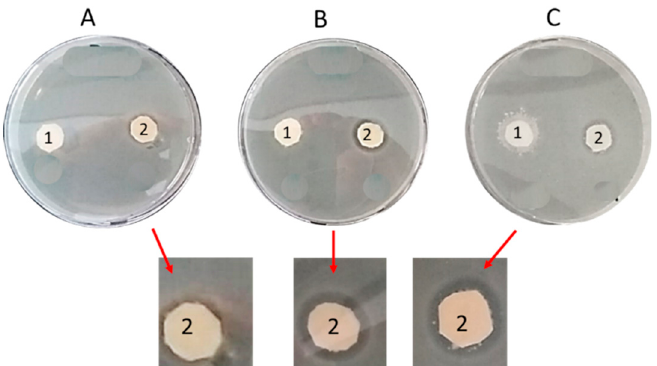
Figure 7. Modified Zone of Inhibition Test of P. aeruginosa after 24 h incubation with reference PP (1) and s-PBC@PP (2) coupons containing a residual volume of water ( A ) and after the spotting of 0.2 mL ( B ) and 0.5 mL ( C ).